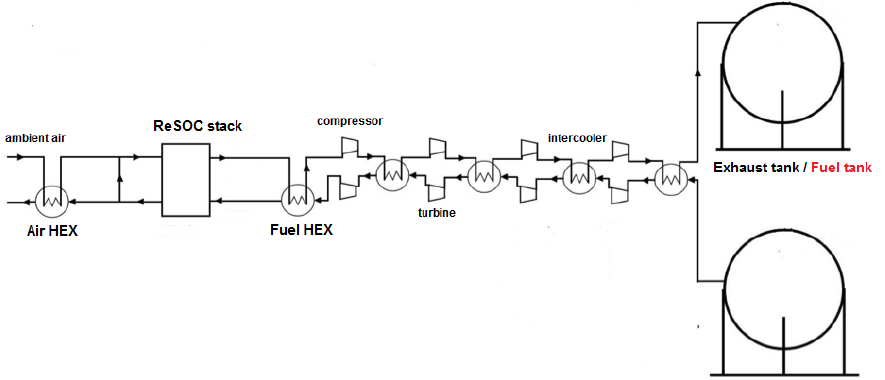
Figure 6. Vapor stored plant configuration. During SOFC mode (in black ), the hydrogen rich gas comes out of the Fuel tank and is expanded in the ReSOC stack while steam rich gas is compressed in the Exhaust tank. During SOEC operation (in red ) steam rich gas is expanded from the Fuel tank to the ReSOC stack and hydrogen rich gas is compressed and stored in the Exhaust